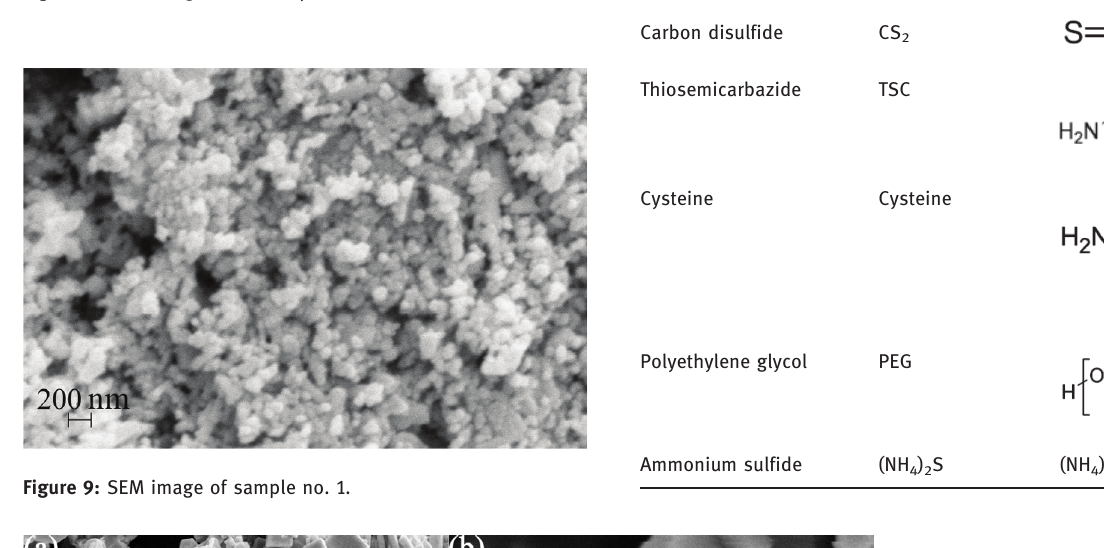
Figure 8: SEM image of Pb complex.